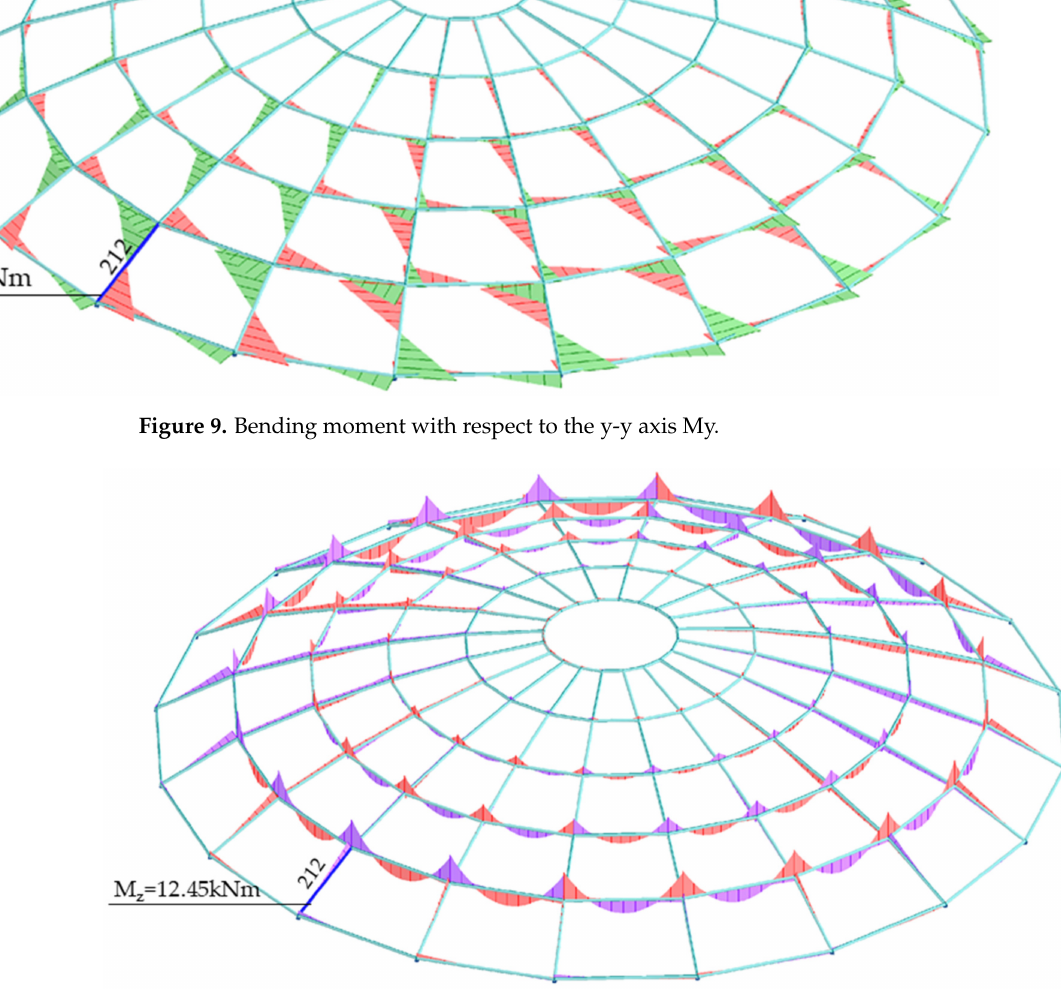
Figure 10. Bending moment with respect to the z-z axis